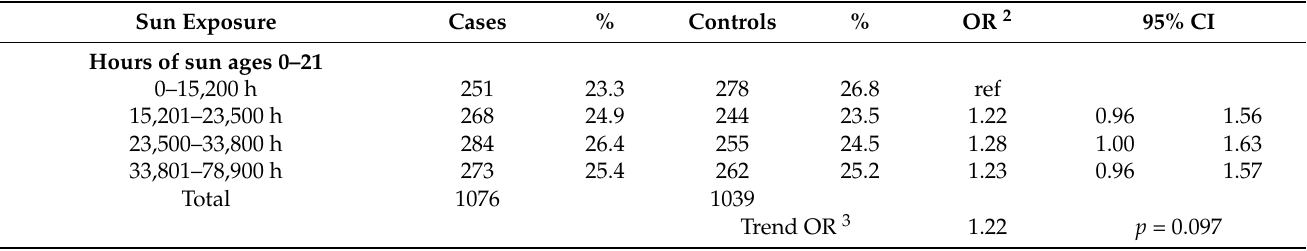
Table 2. Hours of sun exposure between March and October over 20-year time periods and lifetime among 1076 melanoma cases and 1039 population-based controls in Iowa 1